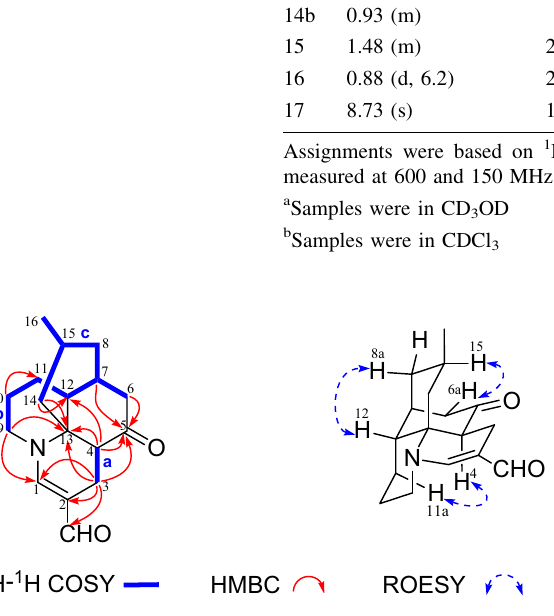
Fig. 2 Key 2D-NMR correlations for compound 1